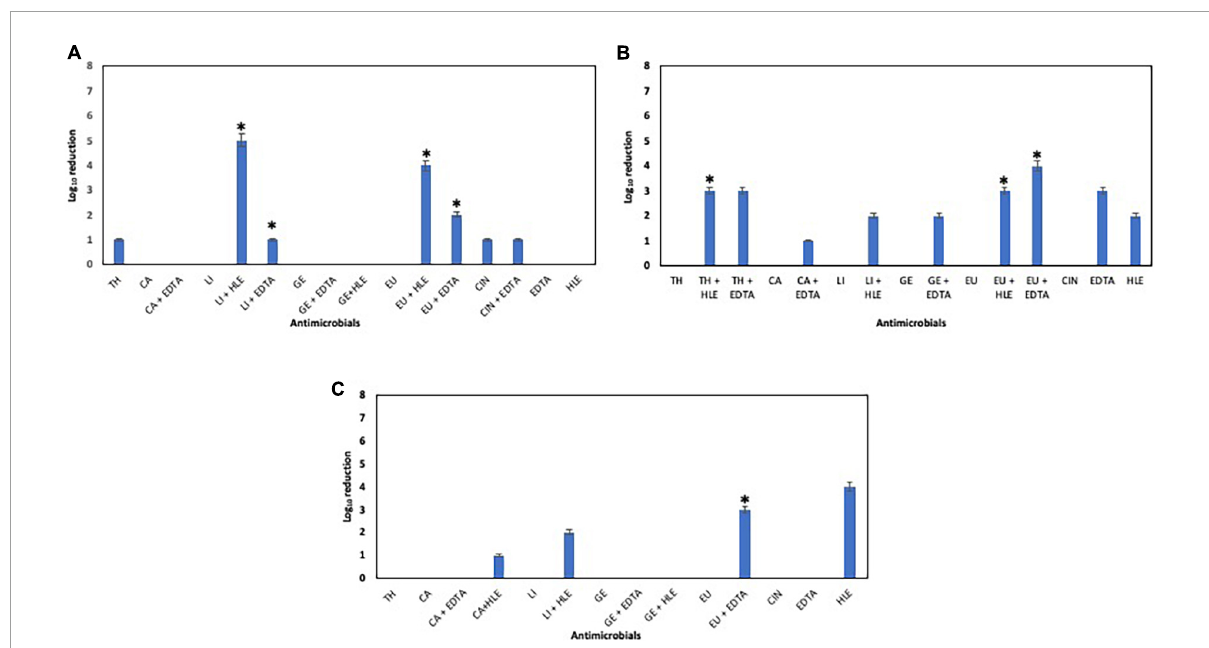
FIGURE7 Log 10 reduction of established biofilms of Pseudomonas strains M13K11 (A) , M22K12 (B) and M33T02.2 (C) after 30 min treatment with EOCs (TH, CA, LI, GE, EU and CIN), EDTA, HLE or their synergistic combinations. *Indicates a statistically significant synergistic effect.